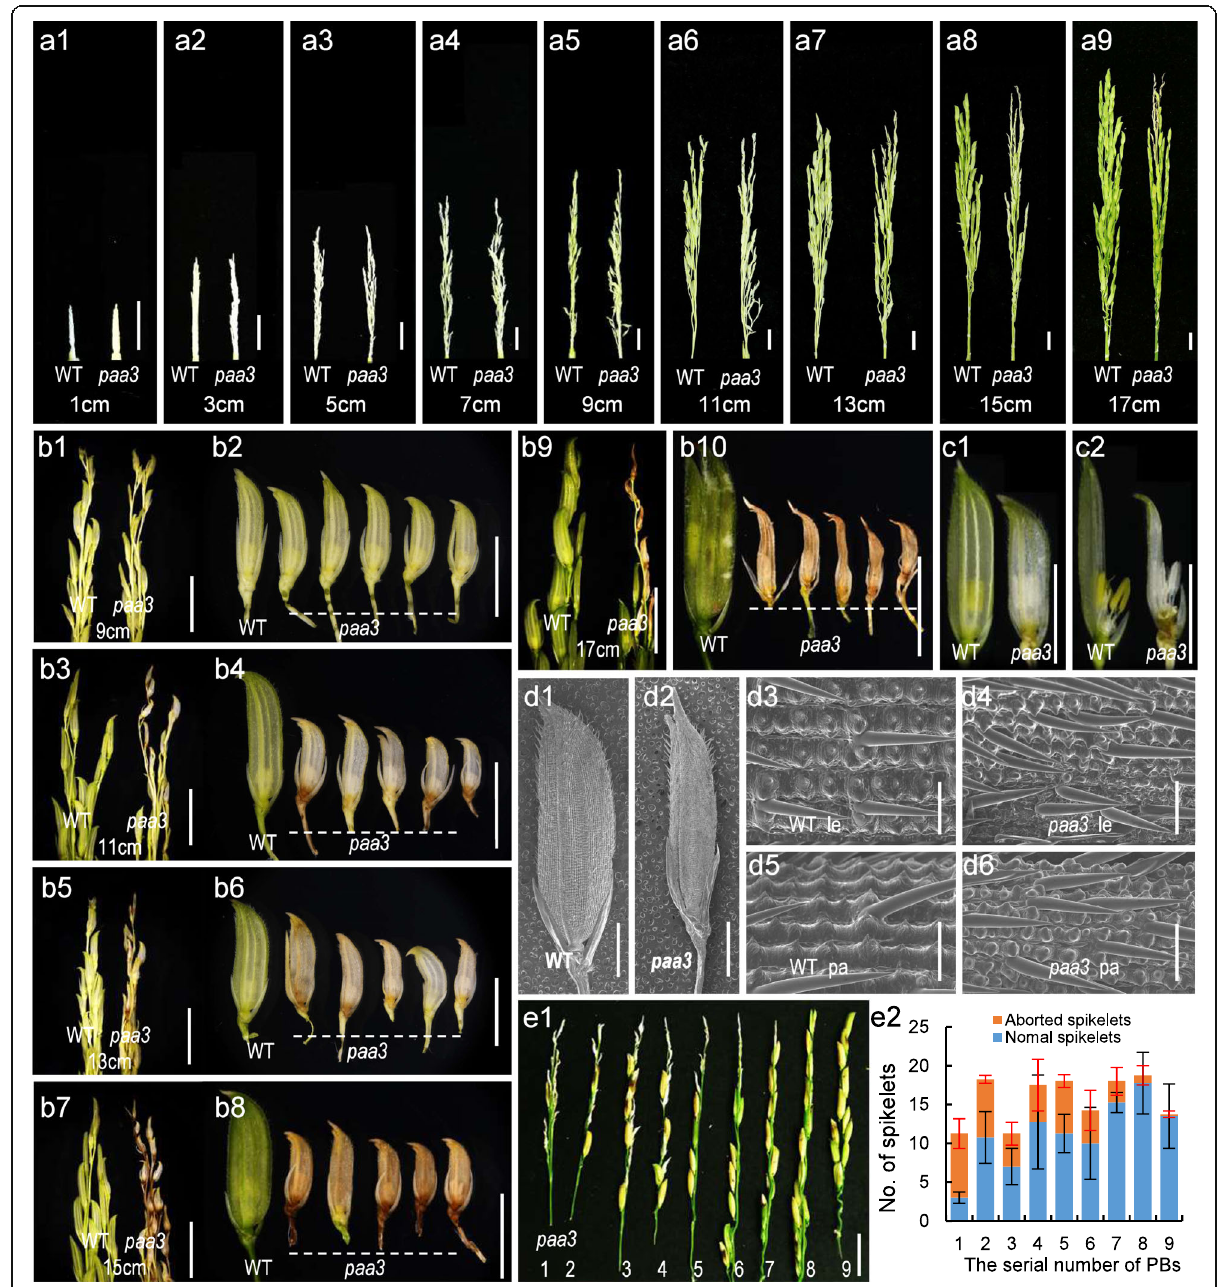
Fig. 2 Characteristics of abortion spikelets. a : Representative images of WT (left) and paa3 (right) developing panicles, showing different stages as indicated by panicle length:1 cm ( a 1), 3 cm ( a 2), 5 cm ( a 3), 7 cm ( a 4), 9 cm ( a 5), 11 cm ( a 6), 13 cm ( a 7), 15 cm ( a 8) and 17 cm( a 9). b : The apical developing panicles, showing different stages as indicated by panicle length: 9 cm ( b 1, b 2),11 cm ( b 3, b 4),13 cm ( b 5, b 6),15 cm ( b 7, b 8),17 cm ( b 9, b 10). c : Top spikelet in paa3 mutants and WT; Total spikelet( c 1), Spikelet without lemma( c 2). (panicle length= 11 cm): d : Scanning electron microscopy observation of top spikelet in paa3 mutant and WT: total spikelet of WT( d 1), total spikelet of paa3 ( d 2), WT lemma ( d 3), paa3 lemma ( d 4), WT palea ( d 5). paa3 palea ( d 6). e : Analysis of the aborted panicle in paa3 : The image of the primary branch of paa3 panicle; Arabic numerals (1 – 9) denote the serial number of PBs(e1), Analysis of degenerated spikelets in each primary branch of paa3 in e 1( e 2). Bars: ( a 1 – a 9, e1)1cm; ( b 1 – b 10 and c 1 – c 2)5mm; ( d 1 – d 2) 2 mm; ( d 3 – d 4) 120 μ electron microscopy to observe the hull development in apical spikelets with ~ 9 cm panicles in WT and paa3 the ~ 11 cm panicles and found the size of the epidemic mutant. And found that the stamen exhibited a hydrated cells in both the lemma and palea of paa3 were smaller phenotype (Fig. 2c1-c2). We further used scanning